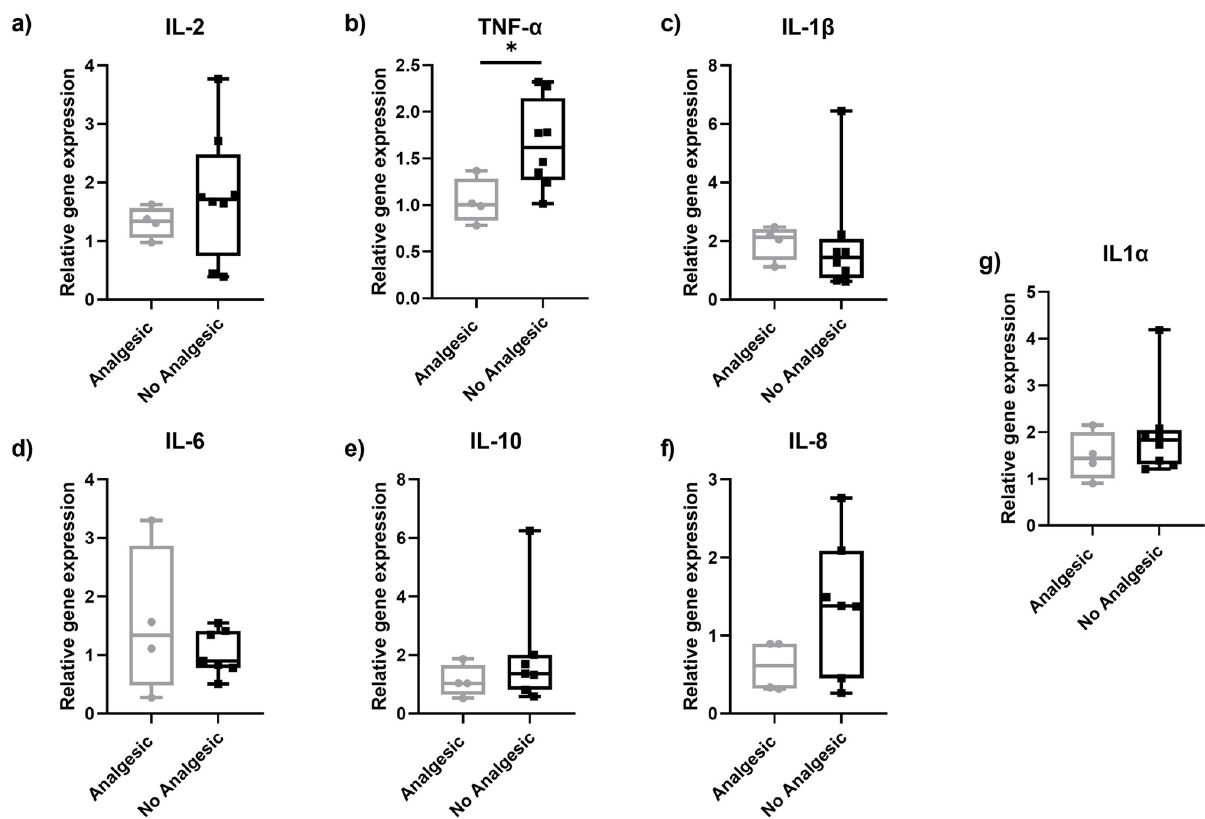
Fig 6. Gene expression of inflammatory mediators in PD Pain treated with analgesics skin punch biopsies obtained from the lateral lower leg. Lower gene expression of TNF- α in PD with pain treated with analgesics compare to those not treated (b). No intergroup differences were found for the investigated markers IL-2 (a), IL-1 β (c), IL-6 (d), IL-10 (e), IL-8 (f), and IL-1 α (g). Data are expressed as median ± range. Abbreviations: IL = interleukin, PD = Parkinson’s disease, TNF- α = tumour necrosis factor alpha. � P < 0.05. Mann-Whitney-U test.